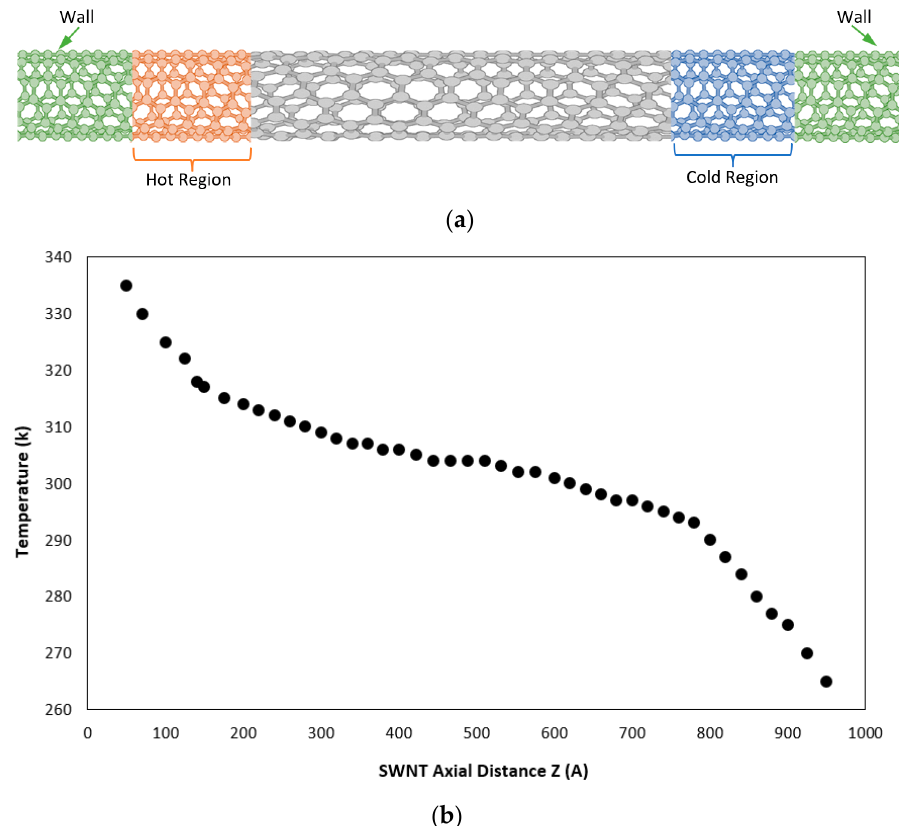
Figure 2. ( a ) Schematic structure of a SWNT used in MD simulations and ( b ) a typical temperature pro fi le along the axial length of a SWNT with a chirality (12, 12).